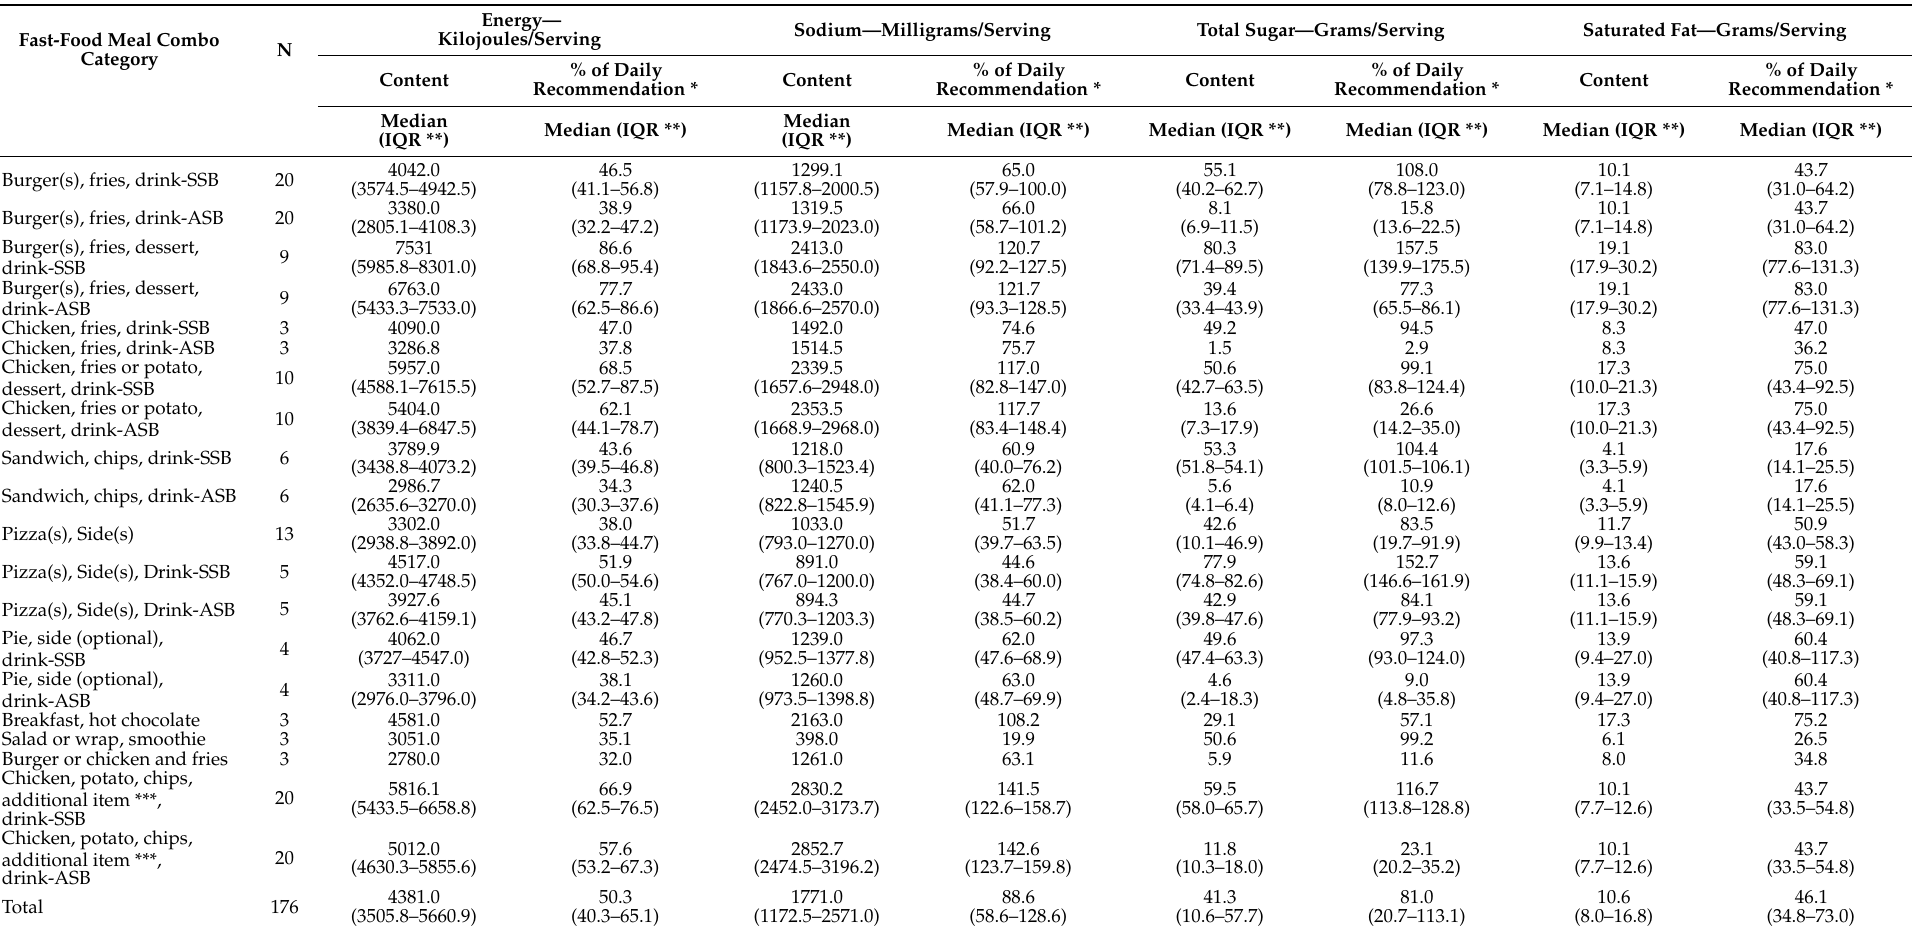
Table 2. NZ fast food supply 2020, by combo types: Median (interquartile ranges) for: energy, sodium sugar and saturated fat content by serving size and for percent energy, sodium, sugar and saturated fat contributions to recommended daily